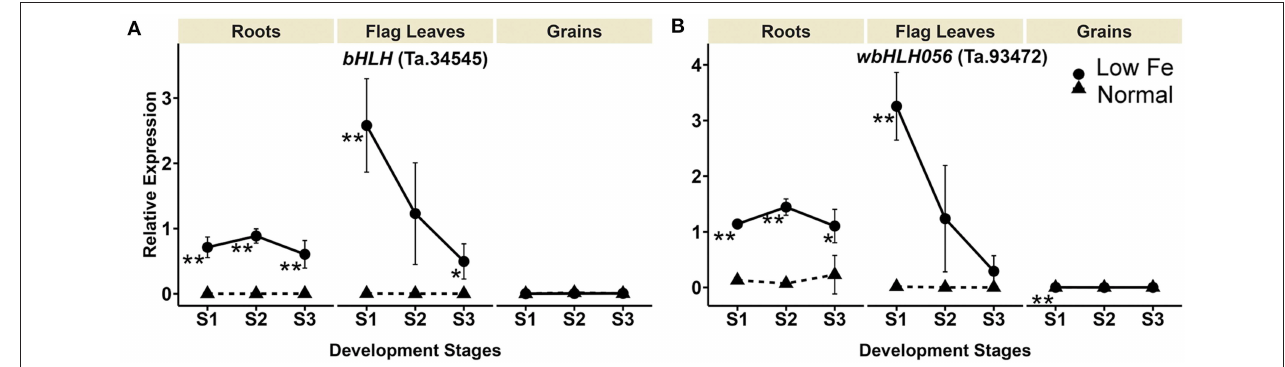
FIGURE 5 | Iron deficiency induced differences in expression levels of wheat homologs of genes encoding transcription factors. The data collected at three different development stages, i.e., 8–10 DPA (stage 1), 25–28 DPA (stage 2), and 33–35 DPA (stage 3) are presented. Values are the mean ± standard deviation of the three biological replicates (* p ≤ 0.05; ** p ≤ 0.01). Note the differences in scale at Y-axis for relative expression levels of tested genes. (A) bHLH (Ta.34545), (B) wbHLH056